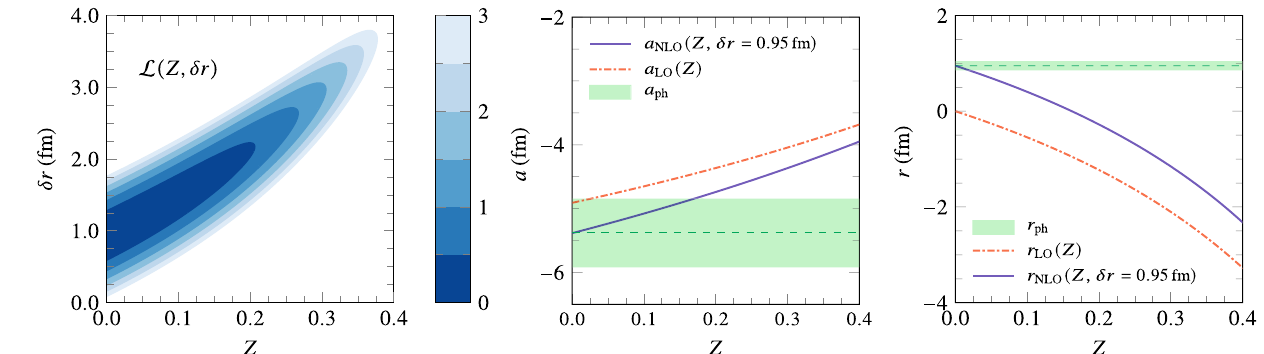
Fig. 4 Left: distribution of Eq. (6) for different values of the proba- bility Z of the T + cc state ending in a bare elementary particle (compact tetraquark), as a function of the NLO contribution δ r [Eq. (5a)] to the effective range of the isoscalar D ¯ D ∗ interaction. Middle and right: Z